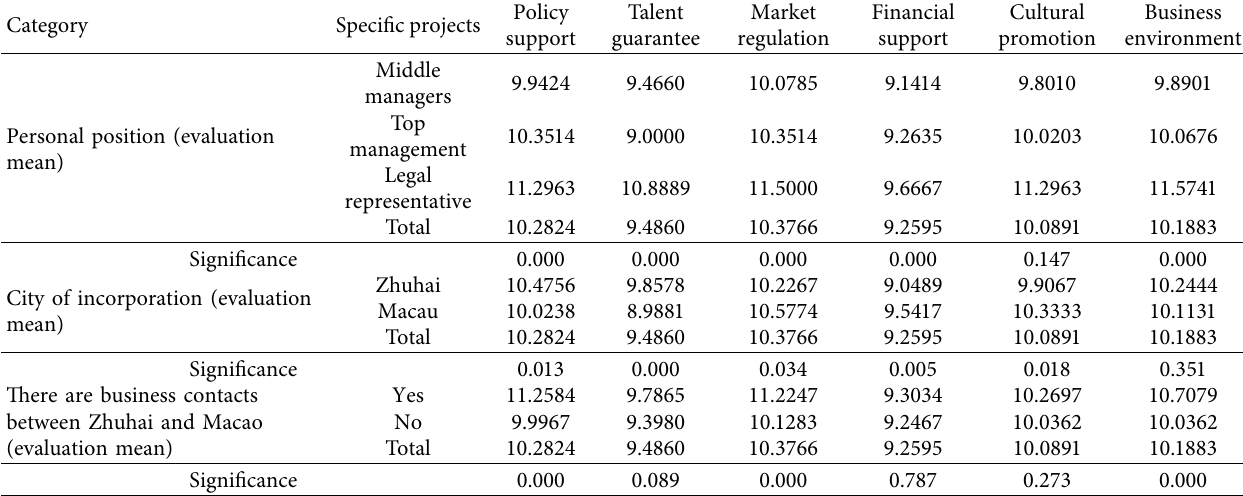
Table 3: One-factor ANOVA table for individual positions, registered cities, and business dealings.